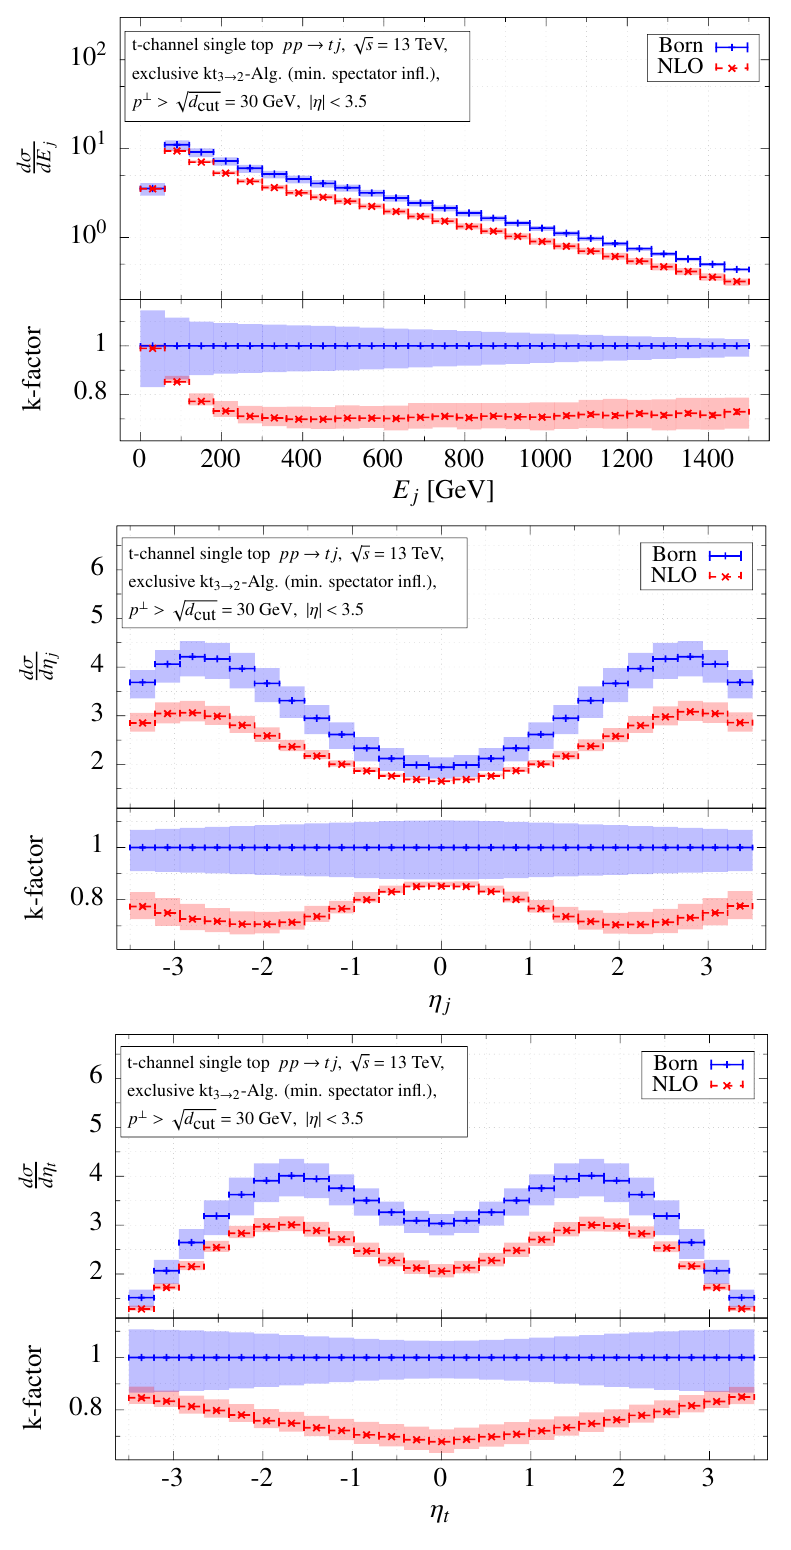
Figure 28 . Same as (cid:12)gure 27 but for the t -channel.